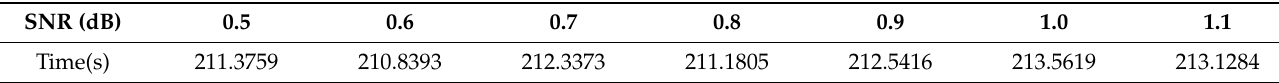
Table 4. Running time at 0.5–1.1 dB.